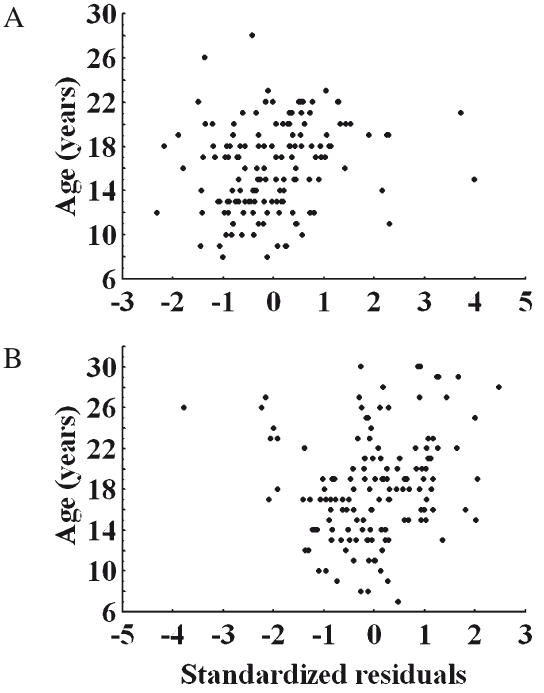
f iG . 7. – Residual plots of age fish versus otolith radius (OR) for females (A) and males